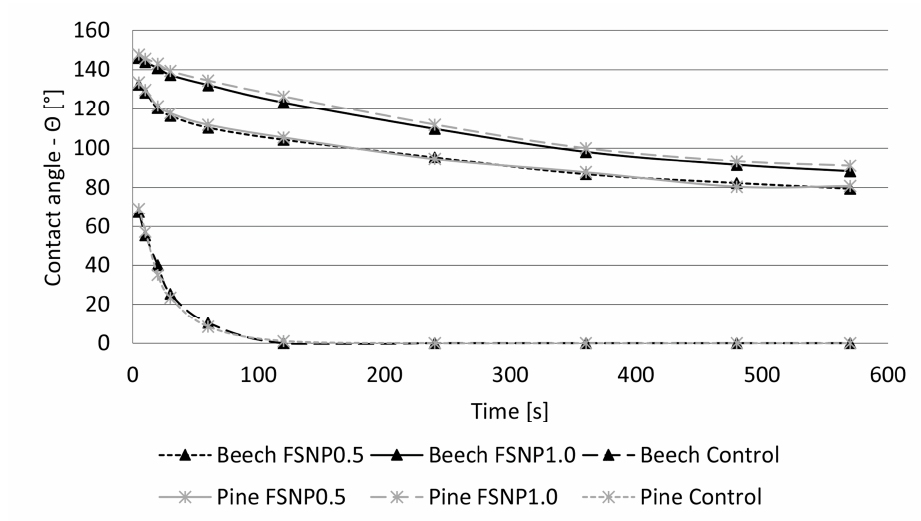
Figure 5. Contact angles as a function of time on control and FSNP-modified beech and Scots pine wood surfaces.